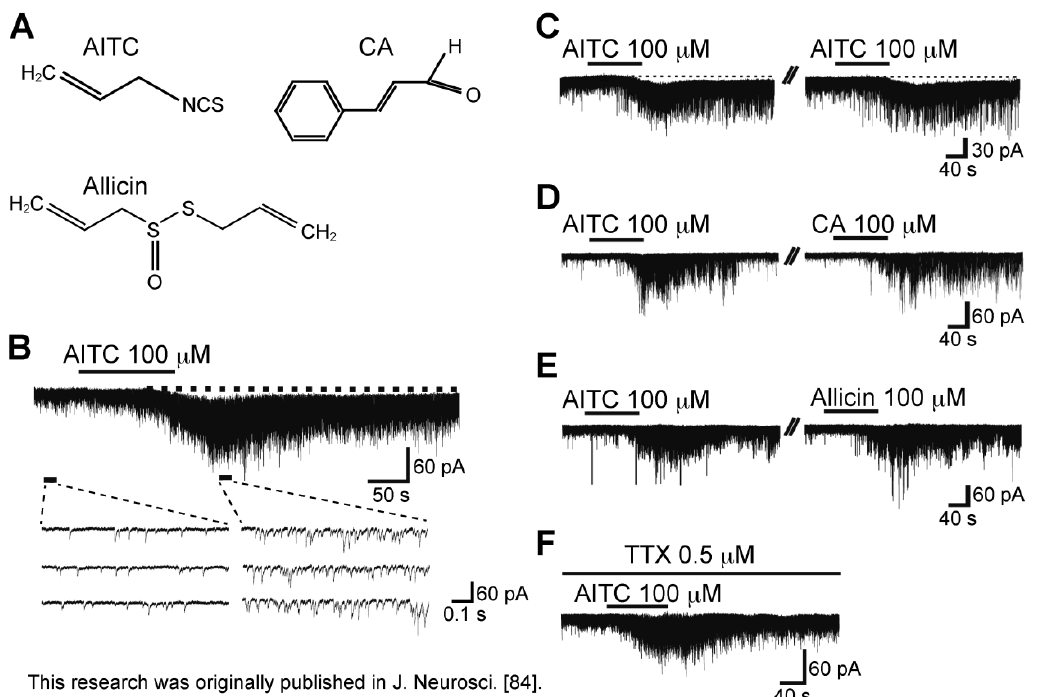
Figure 8. Actions of a TRPA1 agonist allyl isothiocyanate (AITC) and related substances (cinnamaldehyde (CA) and allicin) on spontaneous excitatory transmission in rat SG neurons. ( A ) The chemical structures of AITC, CA and allicin; ( B ) Recording of sEPSCs before and during the action of AITC (100 μM). Note a slow inward current that is accompanied by increases in sEPSC frequency and amplitude; ( C ) When AITC (100 μM) was applied repeatedly at 20 min intervals, it produced similar increases in sEPSC frequency and amplitude and induced an inward current having a similar amplitude ; ( D , E ) CA ( D ) or allicin (each 100 μM); ( E ) increased sEPSC frequency and amplitude in a neuron in which AITC increased sEPSC frequency and amplitude. In each of ( C – E ), the right recording was obtained 15 min after the left one; ( F ) The sEPSC frequency and amplitude increase produced by AITC persisted in the presence of TTX (0.5